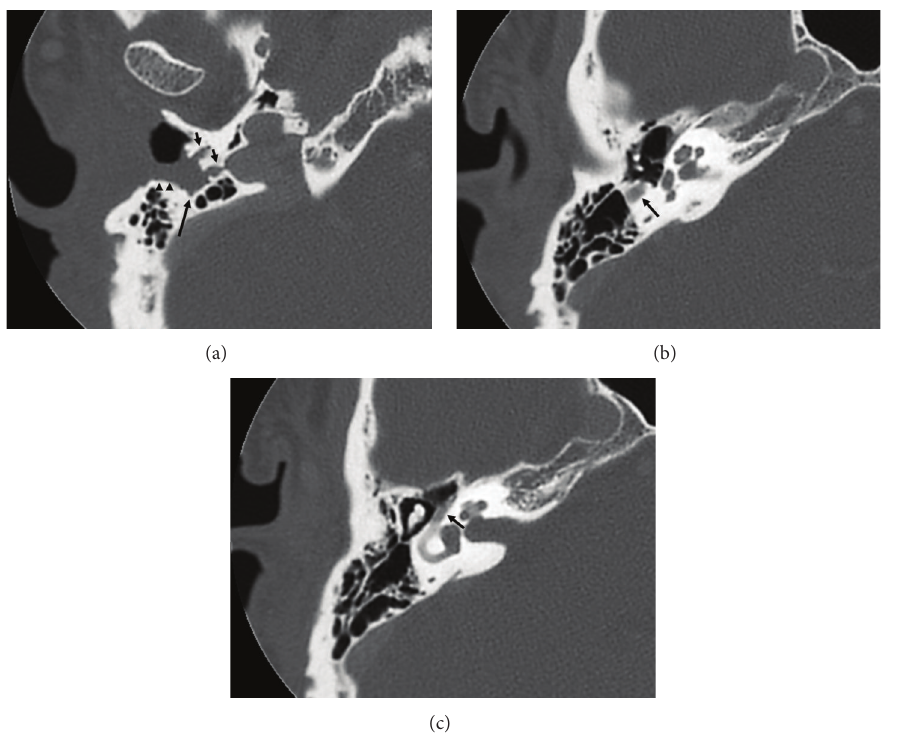
Figure 3: Axial CT images of the right temporal bone. (a) A mass in the stylomastoid foramen (large arrow) is destroying the tympanic bone and mainly spreading outside the bone (arrow heads). Note that, additionally, there is bony destruction on the inward side that might have spread along small branches of the facial nerve (small arrows). (b) The bony canal of the mastoid segment of the facial nerve is enlarged (arrow). (c) The bony canal of tympanic segment of the facial nerve is enlarged (arrow) as compared with the contralateral normal side (not shown).